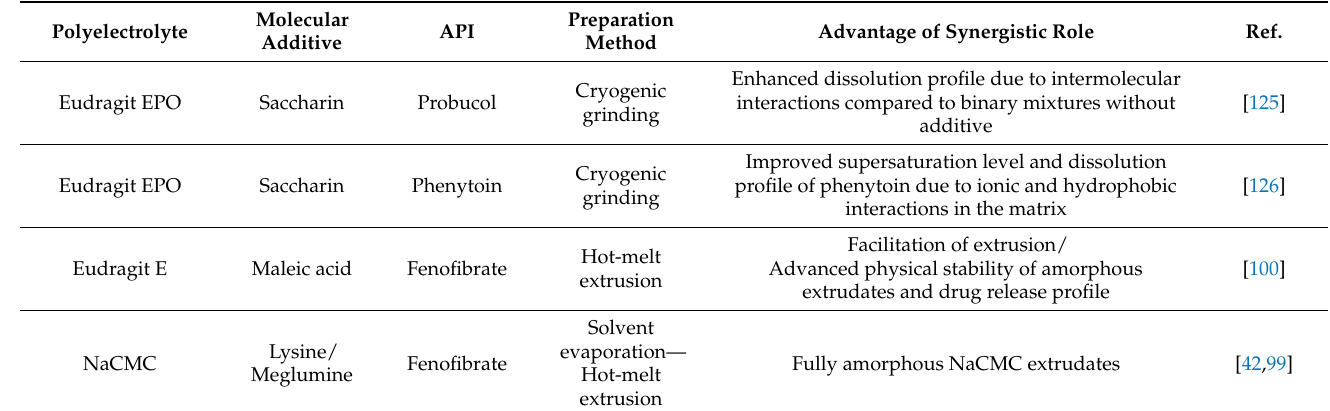
Table 4. Advantages of modified polyelectrolyte